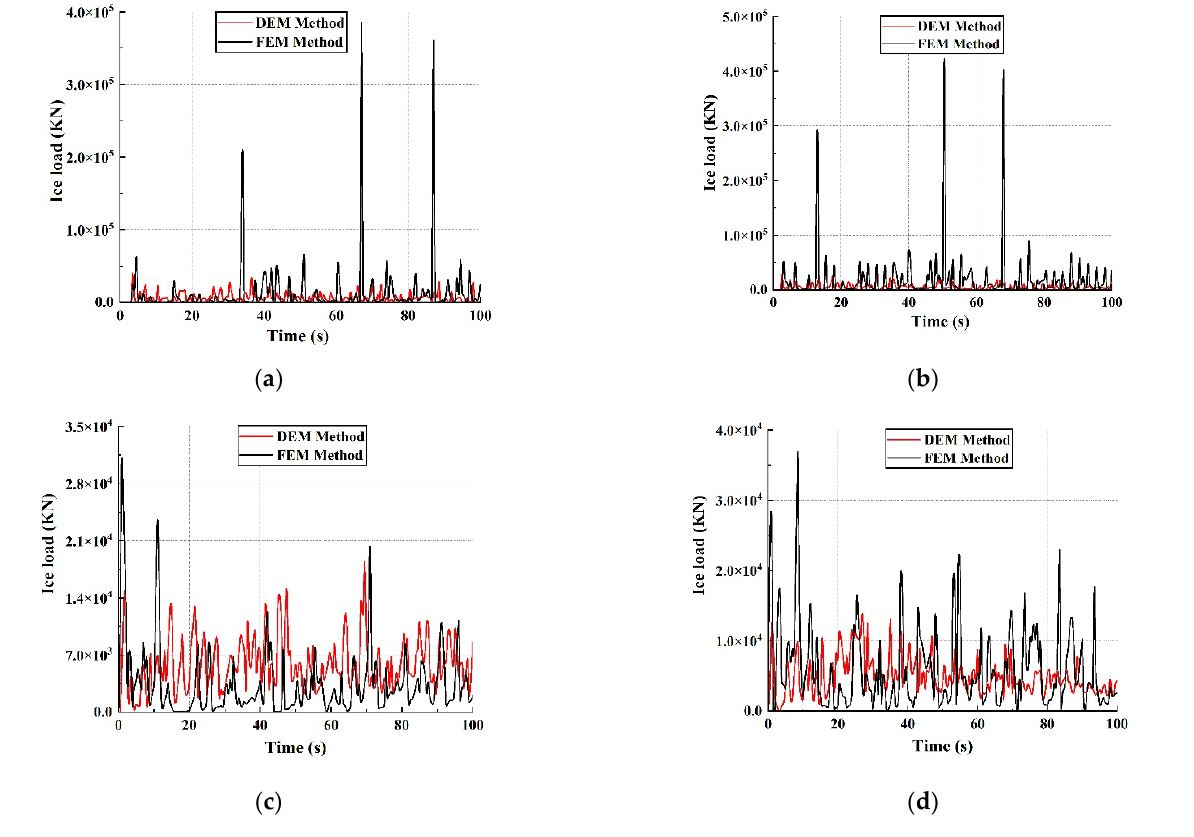
Figure 7. Numerical comparison of ice load between finite element method and discrete element method. ( a ) Cylinder structure at 0.3 m/s ice speed; ( b ) cylinder structure at 0.4 m/s ice speed; ( c ) cone structure at 0.2 m/s ice speed; ( d ) cone structure at 0.4 m/s ice speed. Table 5. The numerical comparison of different ice load analysis